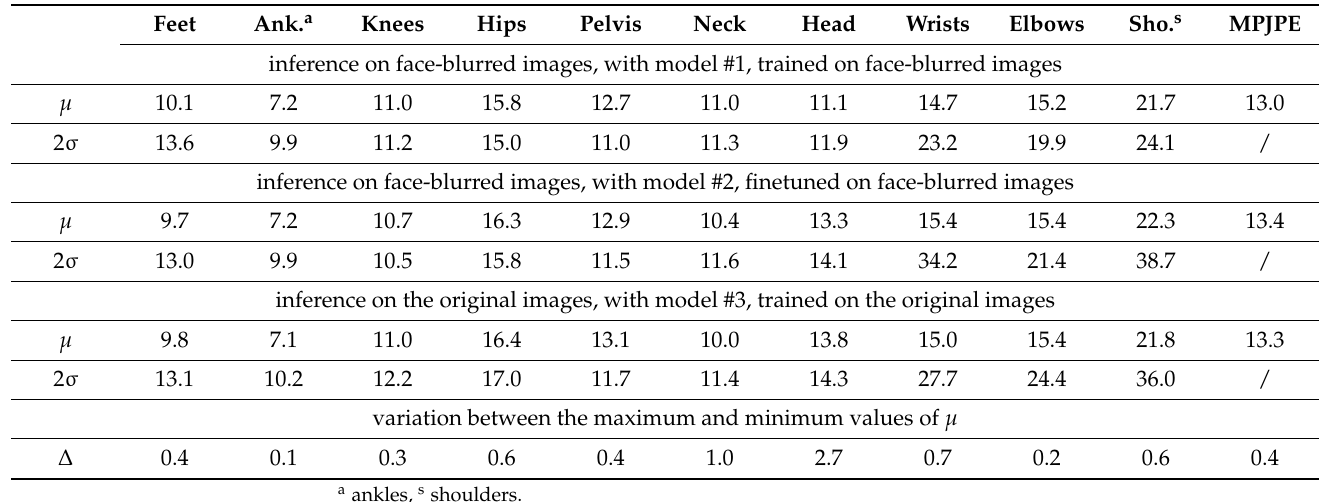
Table 1. Inference results with the models trained on blurred/original images. µ : the mean value of joint position differences with the reference system (mm). σ : standard deviation (mm).